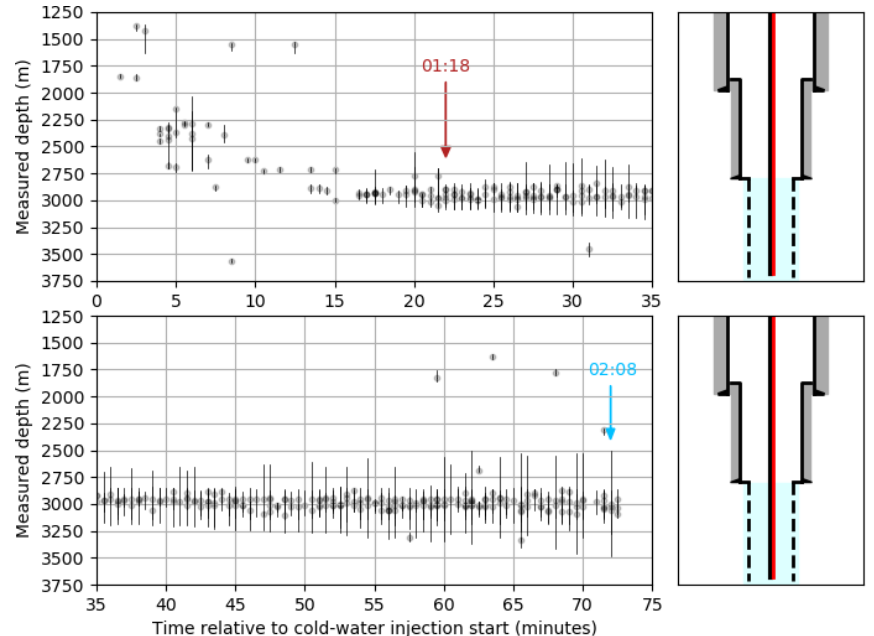
Figure 9. Gray circles and black vertical lines indicate the spatiotemporal origin and spatial extent of vibrational events in the well, respec- tively. The shown period comprises the first 72min of cold-water fluid injection.